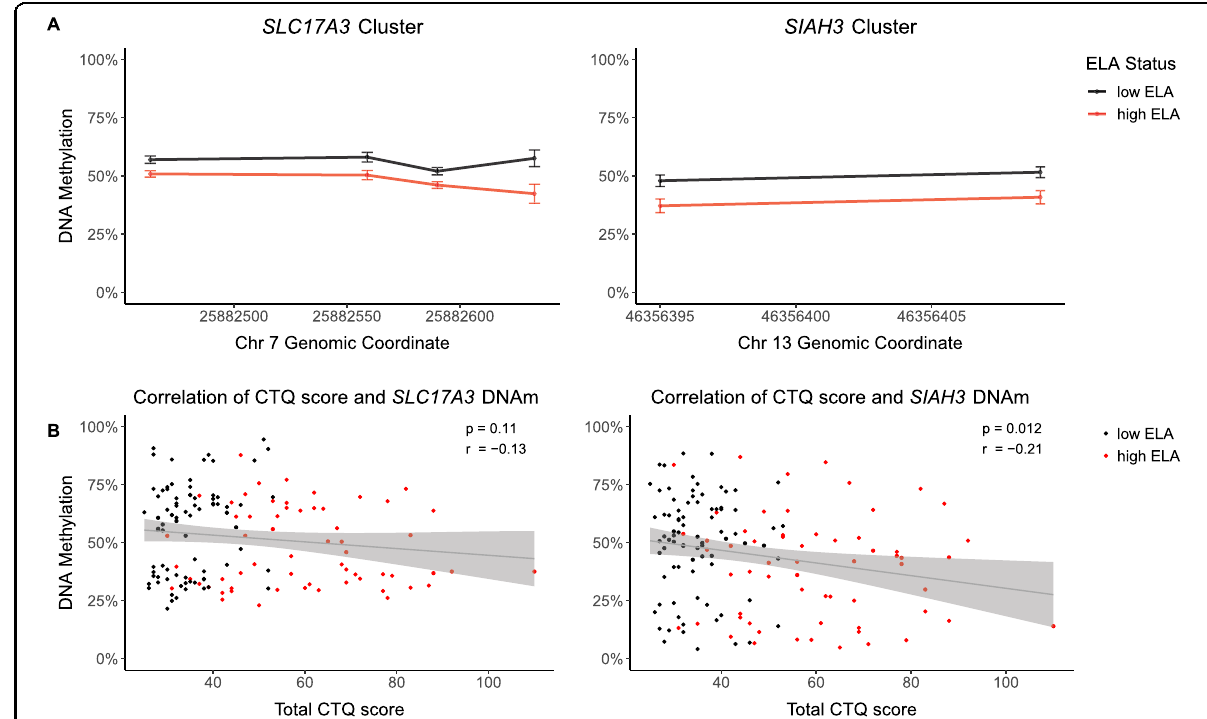
Fig. 2 DMRs with respect to ELA. A Group mean DNAm ± standard error of the top two DMRs associated with ELA ( n = 143). B Correlation of severity of ELA (total CTQ score) with mean DNAm values of the SLC17A3 (left) and SIAH3 cluster (right). Regression line with 0.95 con fi dence interval is